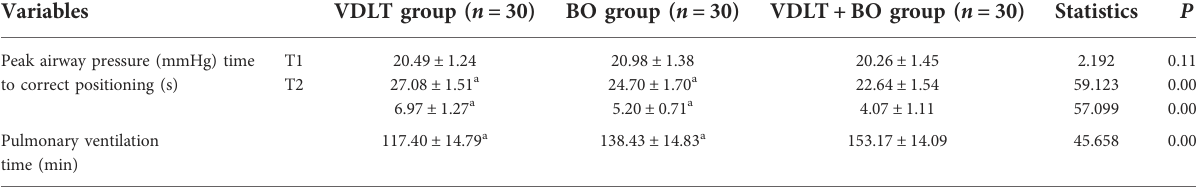
TABLE 2 Comparison of peak airway pressure, time to correct positioning and pulmonary ventilation time before and after intubation . Variables